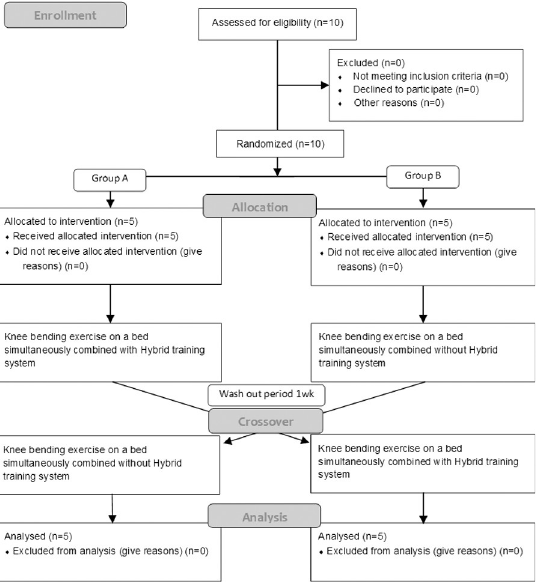
Fig 1. Flow diagram. Subjects were randomly allocated to group A (the knee bending exercise test with Hybrid training system was performed firstly) or group B (the knee bending exercise test without Hybrid training system was performed firstly) and then transitioned to the alternative exercise test on different days separated by an interval of one week as a wash out period.